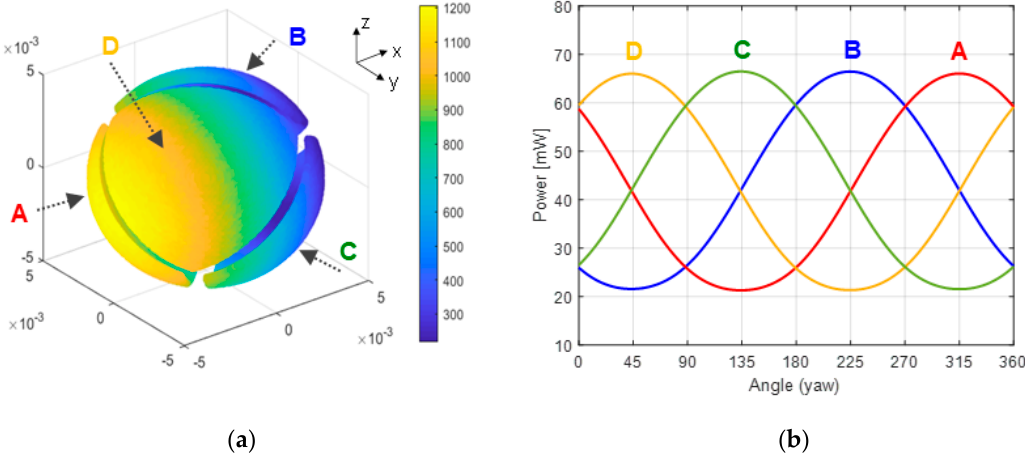
Figure 13. ( a ): Sensor geometry used in the simulations and local heat flux (W/m 2 ) for 𝛥𝑇 = 49 ° C obtained on the surface when the incident wind is parallel to the x -axis. ( b ) Power delivered to each sector as a function of the yaw angle (rotation around the z -axis). The sectors (A, B, C and D) follow the same disposition as the one shown in (a) or Figure 11